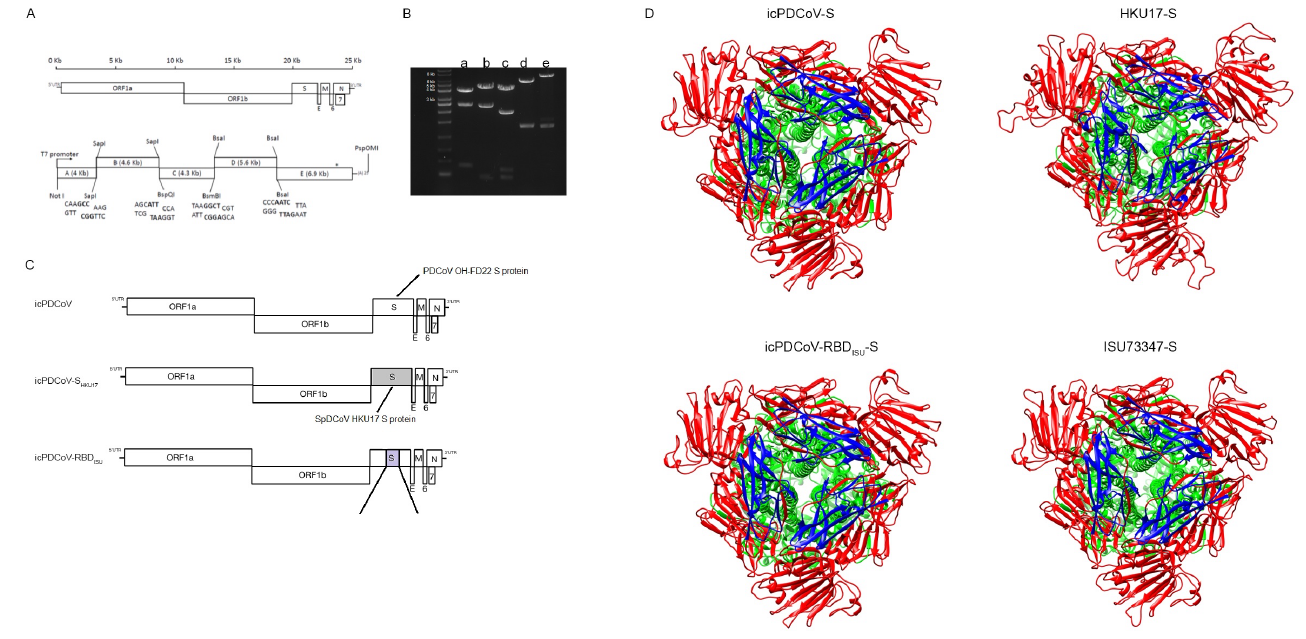
Figure 1. Schematic of the full-length porcine deltacoronavirus (PDCoV) genome and construction of the infectious PDCoV cDNA clone. ( A ) The upper panel is the PDCoV genome, including ORF1a, ORF1b, and the spike (S), envelope (E), membrane (M), ORF6, ORF7, and nucleocapsid (N) genes. The lower panel is cDNA fragments comprising icPDCoV. Restriction sites joining fragments are shown. ( B ) Lanes a, b, c, d, and e correspond to the agarose electrophoresis of the digested plasmids containing fragments A, B, C, D, and E. ( C ) Diagram of engineered S protein in chimeric viruses. ( D ) 3D model of the structure of S proteins homo-trimer from recombinant viruses and SpDCoV ISU73347. [S1 domain (in red), S2 domain (in green), RBD (in